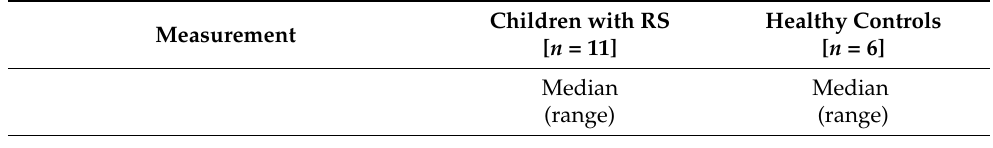
Table 5. Comparison of skeletal cephalometric measurements according to Hasund analysis [42], Posterior airway space (PAS) and soft tissue cephalometric analysis according to A.M. Schwarz [36,37] comparing children with Robin sequence (RS) against the healthy control